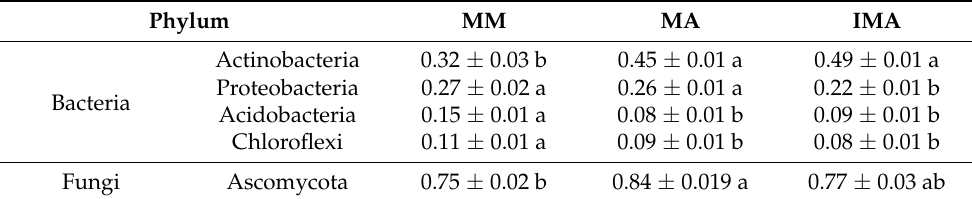
Table 2. Effects of intercropping on the relative abundance of phylum level dominant bacteria and fungi.